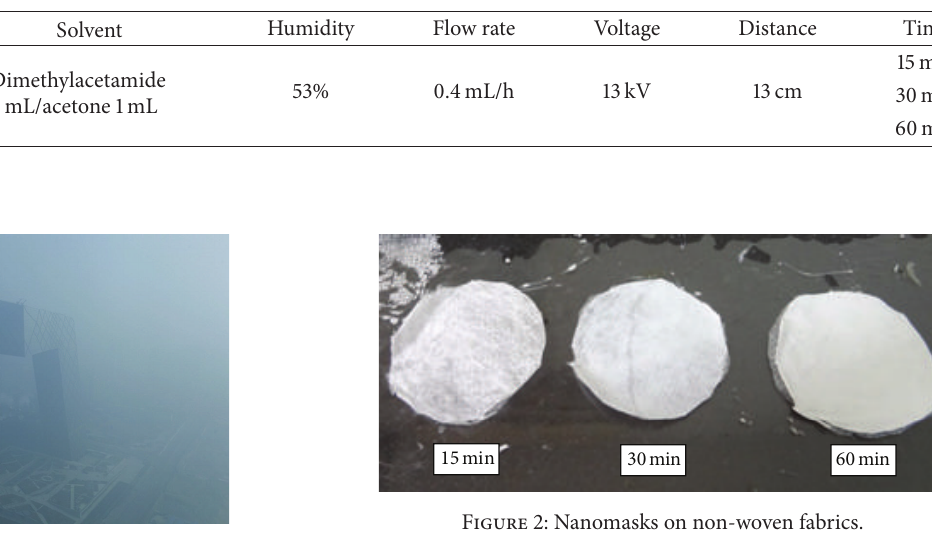
Table 1: Electrospinning conditions.